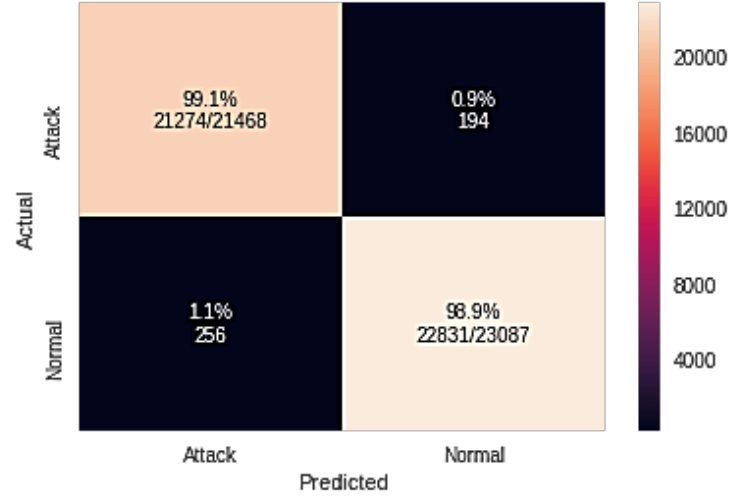
Figure 17. Random forest classification